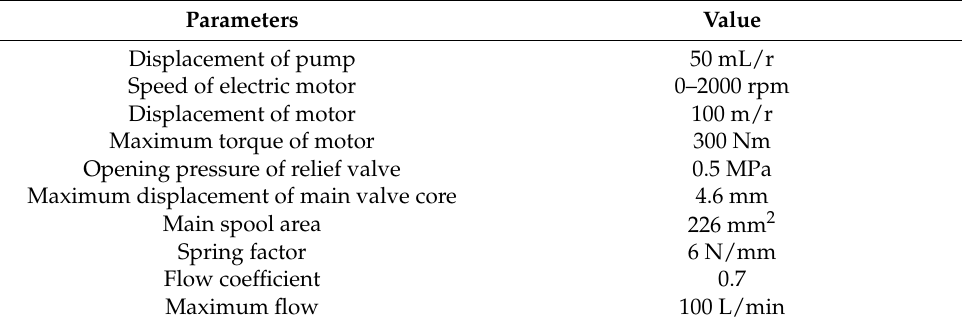
Figure 14. The simulation model. Table 1. Parameters of components in the system.